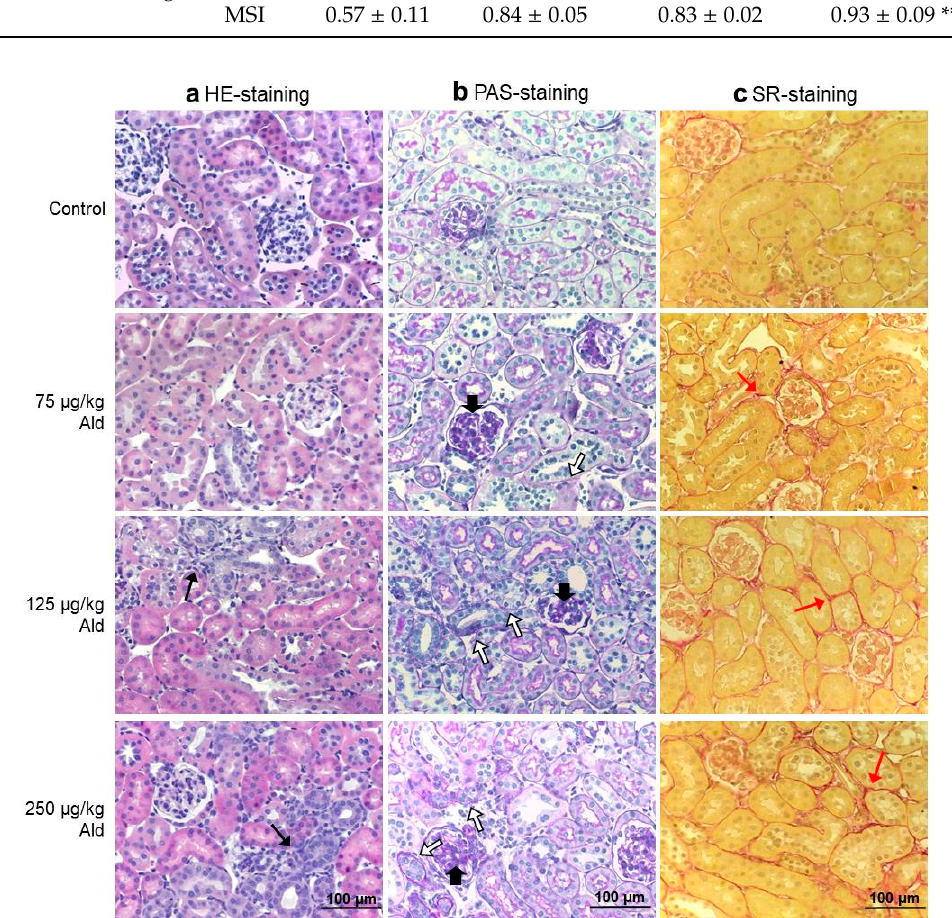
Figure 2. Histopathological changes in kidneys of control and aldosterone-treated mice. ( a ) Representative pictures of hematoxylin and eosin (HE) stained tissue for visualization of inflammatory regions. ( b ) Representative pictures of periodic acid–Schiff (PAS) stained kidney sections for visualization of basal membrane atrophy. ( c ) Representative pictures of Sirius red (SR) stained tissue for visualization of collagen deposition (red). Black narrow arrows: migrated leukocytes as a marker of beginning inflammation. Black broad arrows: examples of sclerotic tissue in glomeruli. White filled arrows: examples of atrophic basal membranes. Red arrows: collagen deposition. Ald: aldosterone. Quantification of circling cytokines in serum revealed no consistent and even no dose-dependent e ff ect of the three aldosterone doses (Table S1). The only significant e ff ect was observed for IL-17A in the middle aldosterone